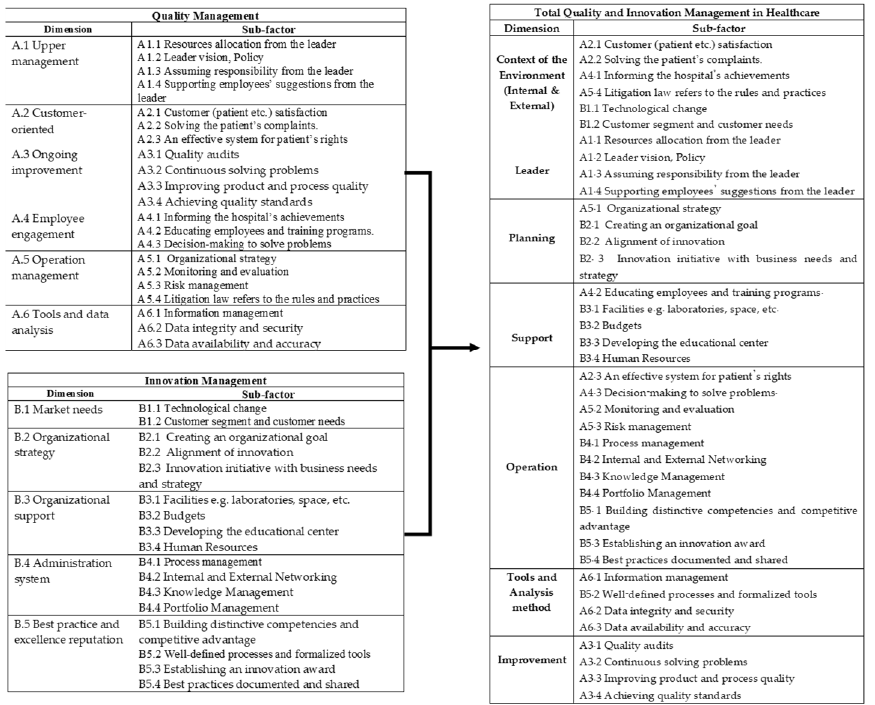
Figure 3. The integration of TQIM-H. Code A: Quality management in healthcare factor, Code B: Innovation management in healthcare factor.